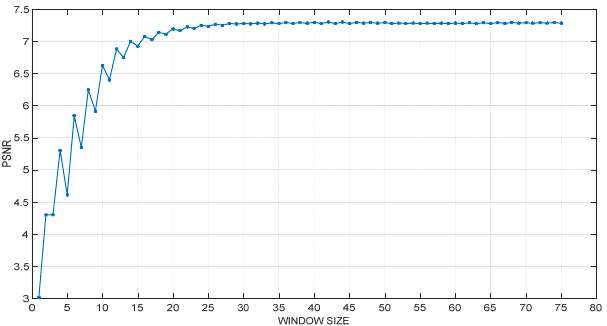
Figure 4. Image P1. Figure 5. PSNR values after P1 processing. Figure 5. PSNR values after P1 Figure 5. PSNR values after P1 processing.